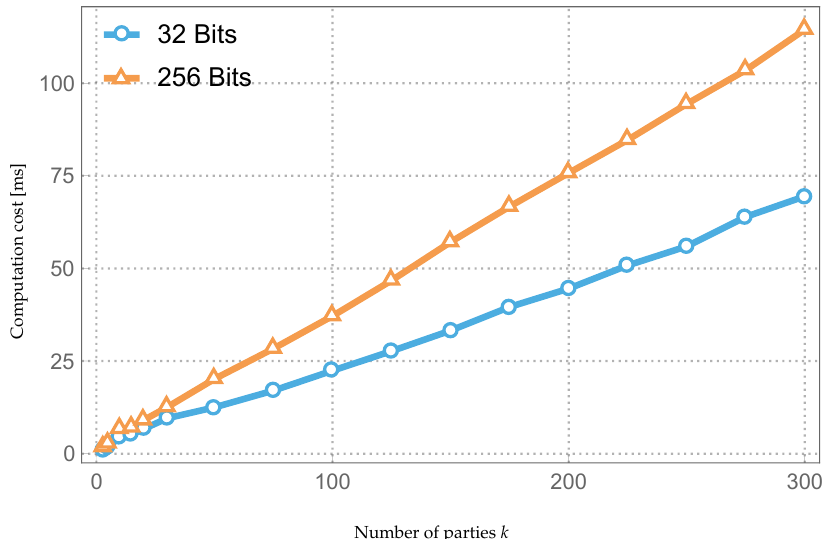
Figure 5. Computation cost of shares generation plus signature and encryption.